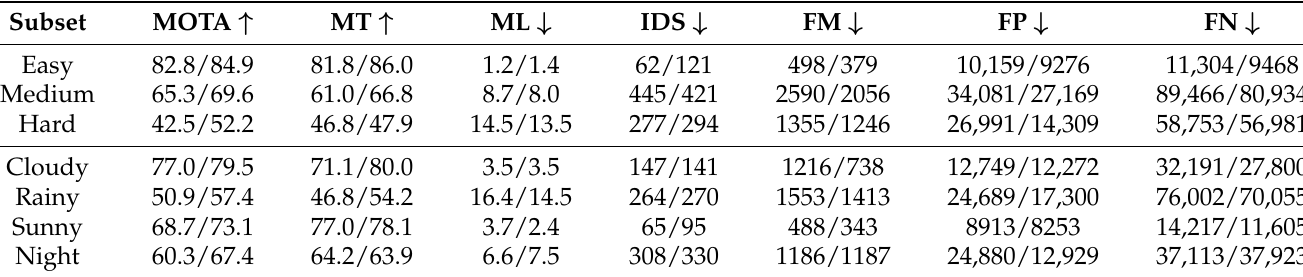
Table 4. MOT results of our single-shot MOT system and FairMOT, which are evaluated on the UA-DETRAC-test subsets using the CLEAR MOT metrics. The scores on the left side indicate the results of FairMOT, while those on the right side indicate the results of our single-shot MOT